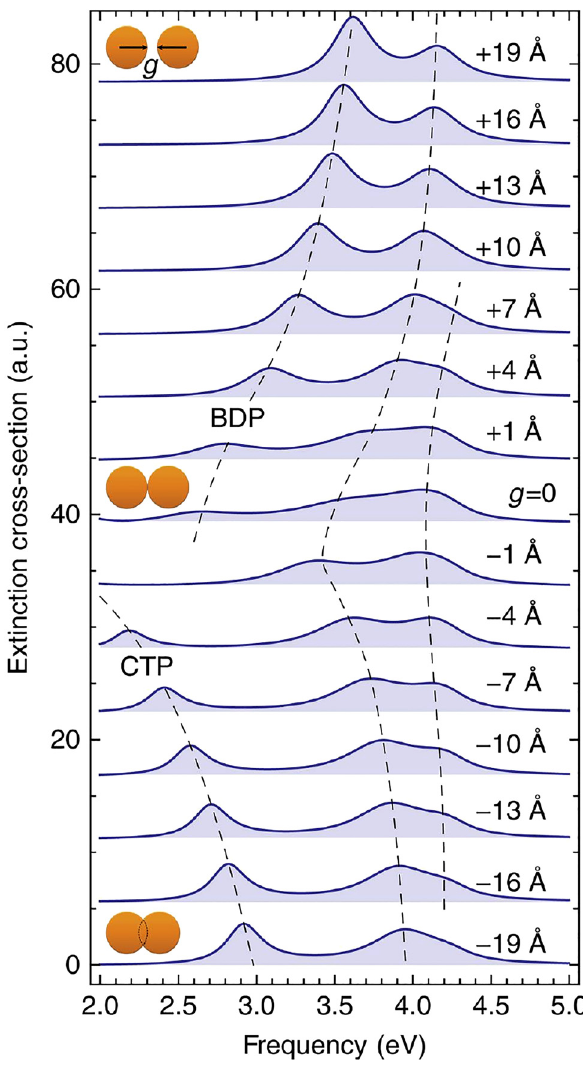
Figure 8: Hybridization and gap-dependent broadening in sodium nanowire dimers. The radius of the sodium wires is R = 4 . 9 nm with the gap g varying from − 19 to + 19 Å. Progressively stronger hybridization occurs as the gap narrows, with both a clear redshift and broadening of the bonding-dipole plasmon. As the gap closes, the charge transfer plasmon (CTP) develops and blueshifts as the wires start to overlap ( g < 0). Higher-order modes (also indicated by dashed lines) exhibit hybridization and broadening too. The diff- usion ( 𝒟 = 1 . 36 × 10 − 4 m 2 /s) causes GNOR spectra in